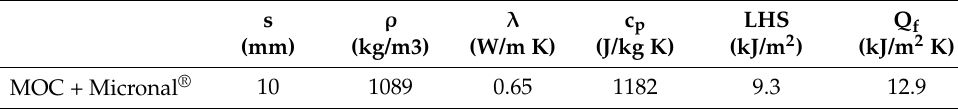
Table 4. Enthalpy–temperature function of MOC with Micronal